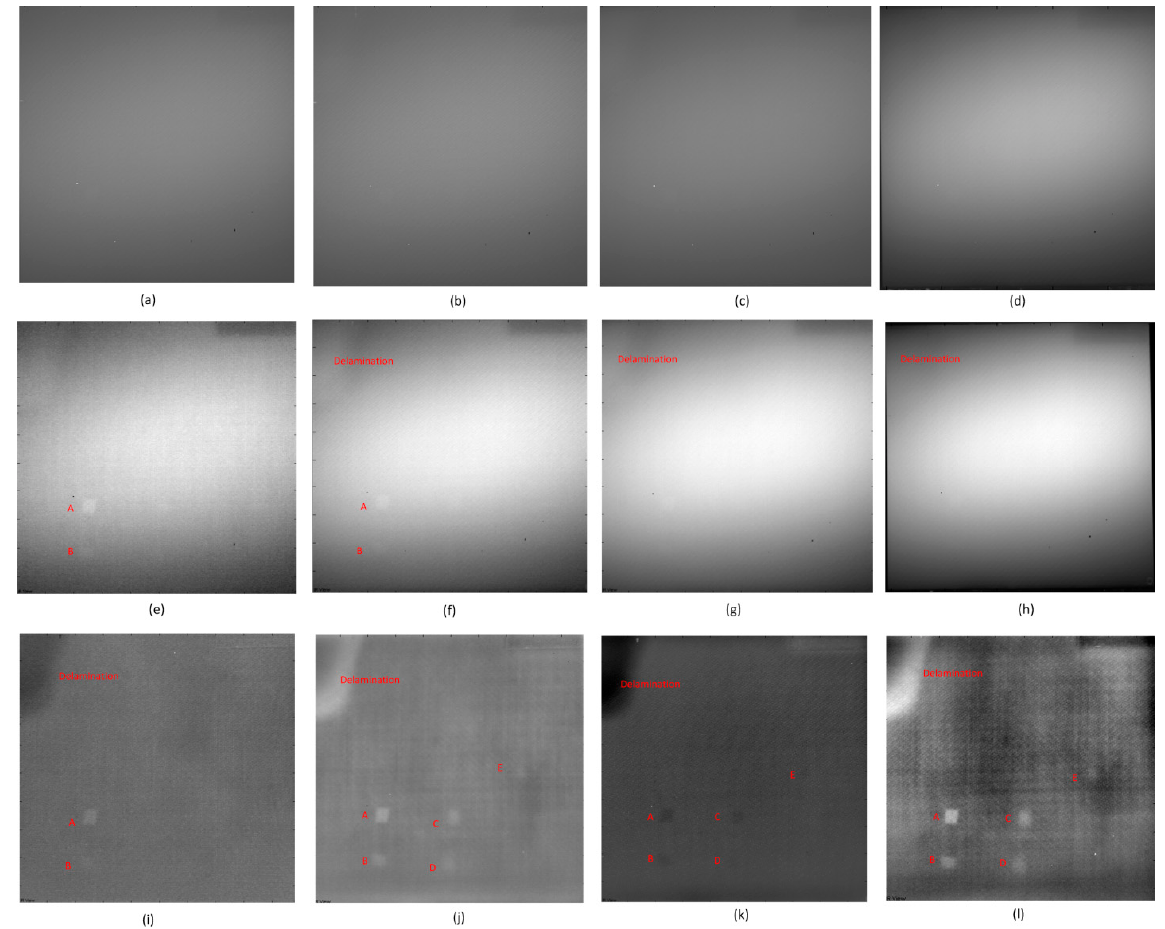
Figure 4. The lock-in thermography results, ( a ) Raw image: 3 Hz; ( b ) Raw image: 1 Hz; ( c ) Raw image: Figure 4: The lock ‐ in thermography results, (a) raw image: 3 Hz, (b) raw image: 1 Hz, (c) raw image: 0.4 Hz, (d) raw 0.4 Hz; ( d ) Raw image: 0.05 Hz; ( e ) CIS: 3 Hz; ( f ) CIS: 1 Hz; ( g ) CIS: 0.4 Hz; ( h ) CIS: 0.05 Hz; ( i ) PCT: image: 0.05 Hz, (e) CIS: 3 Hz, (f) CIS: 1 Hz, (g) CIS: 0.4 Hz, (h) CIS: 0.05 Hz, (i) PCT: 3 Hz, EOF 4, (j) PCT: 1 Hz, EOF 5, (k) 3 Hz, EOF 4; ( j ) PCT: 1 Hz, EOF 5; ( k ) PCT: 0.4 Hz, EOF 4; ( l ) PCT: 0.05 Hz, EOF PCT: 0.4 Hz, EOF 4, (l) PCT: 0.05 Hz, EOF 7.